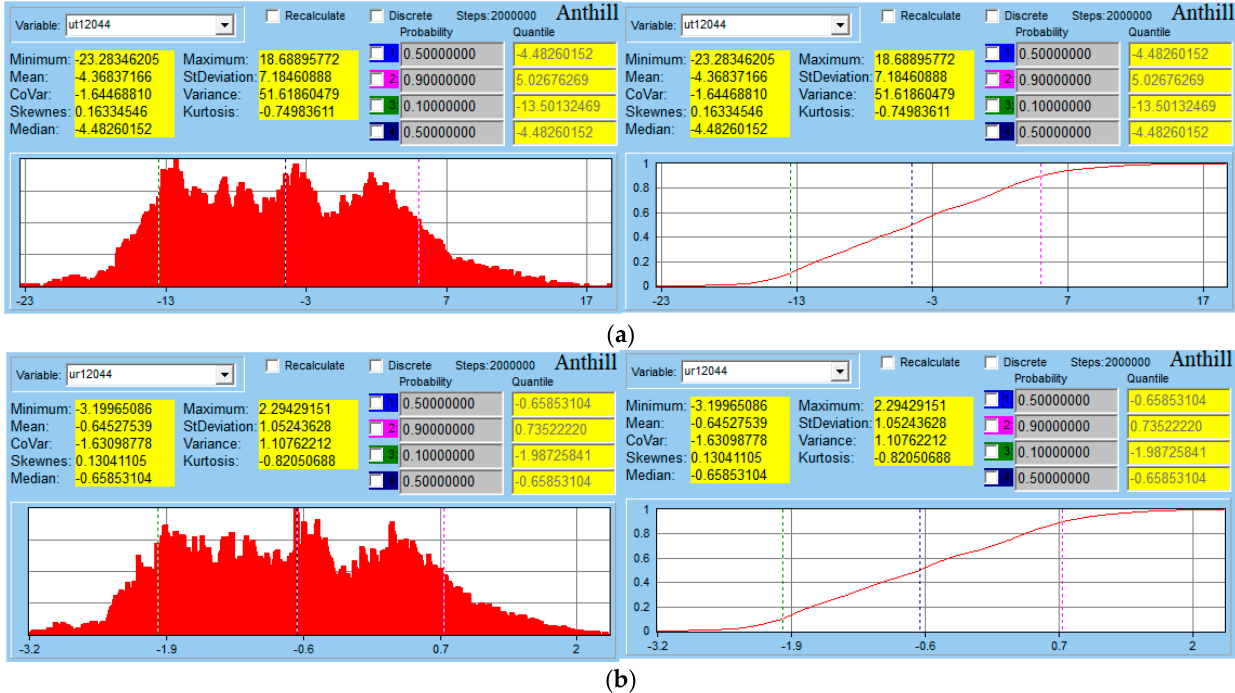
Figure 14. Histograms and distribution functions for node ‘7094’ ( a ) tangential components of crustal surface displacement, ( b ) radial components of crustal surface displacement (sw MSC.Marc Mentat and Anthill).